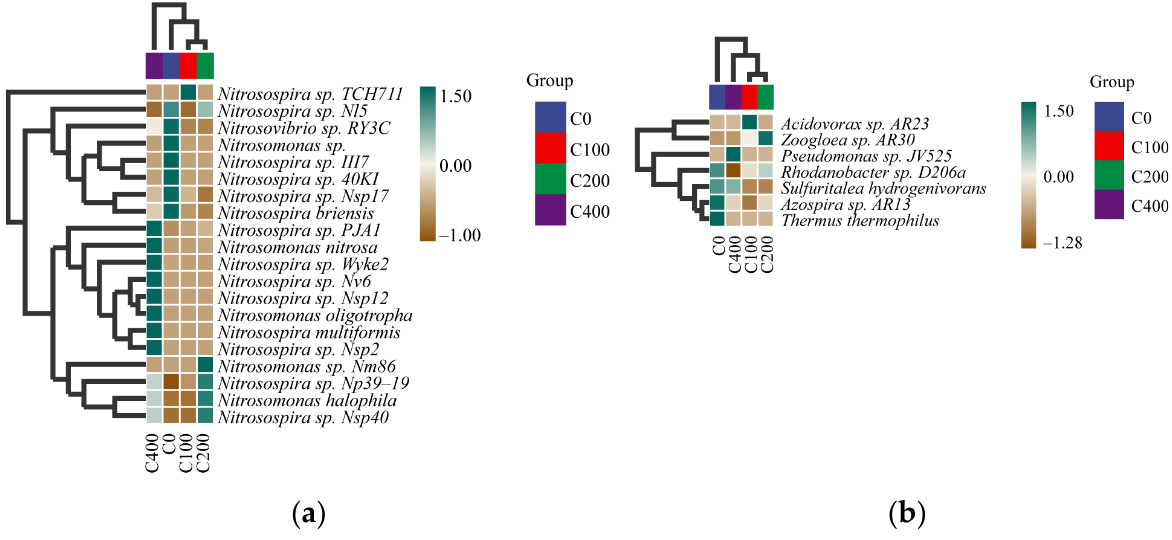
Figure 7. Heat maps of nitrifying ( a ) and denitrifying ( b ) bacterial species composition (at species level).